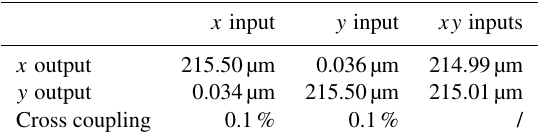
Table 3. Cross coupling in two